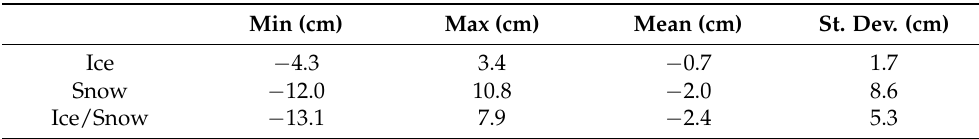
Table 4. In situ losses (negative values) and gains (positive values) of the different surface types during the summer season